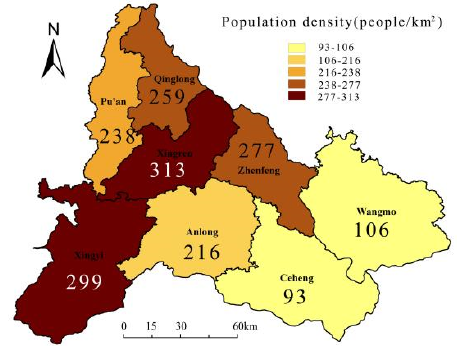
Figure A2. Population density of 8 counties (2016).